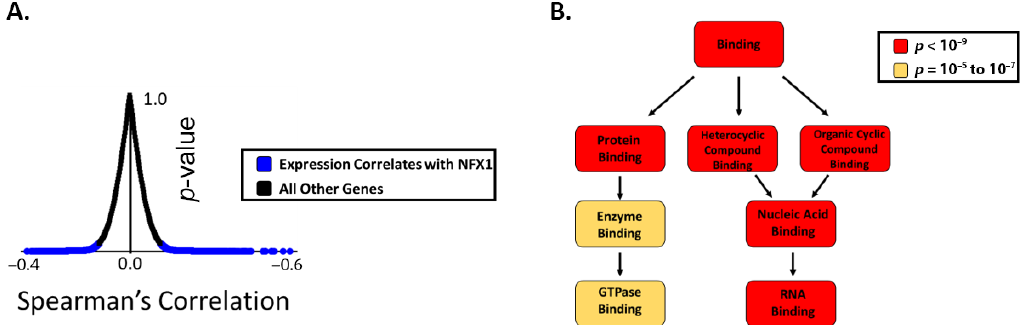
Figure 1. The expression of genes involved in RNA binding correlates with NFX1 expression in cervical cancer. ( A ) Plot showing the distribution of genes in the TCGA database graphed based on the extent to which their expression correlates with NFX1 on the x -axis (Spearman correlation coefficient) and the significance of this correlation ( p -value). Those with a p -value less than 0.05 are shown in blue and considered genes with expression that correlates with NFX1 expression. All other genes are represented as black dots. ( B ) A gene ontology analysis was performed on the genes that significantly correlated with NFX1 expression (using GOrilla software). The output of this analysis is shown. Gene ontology terms are shown in boxes. The color of the box denotes the statistical significance of the enrichment, with darker colors represented greater significance. Arrows indicate increasing specificity of the gene ontology terms.